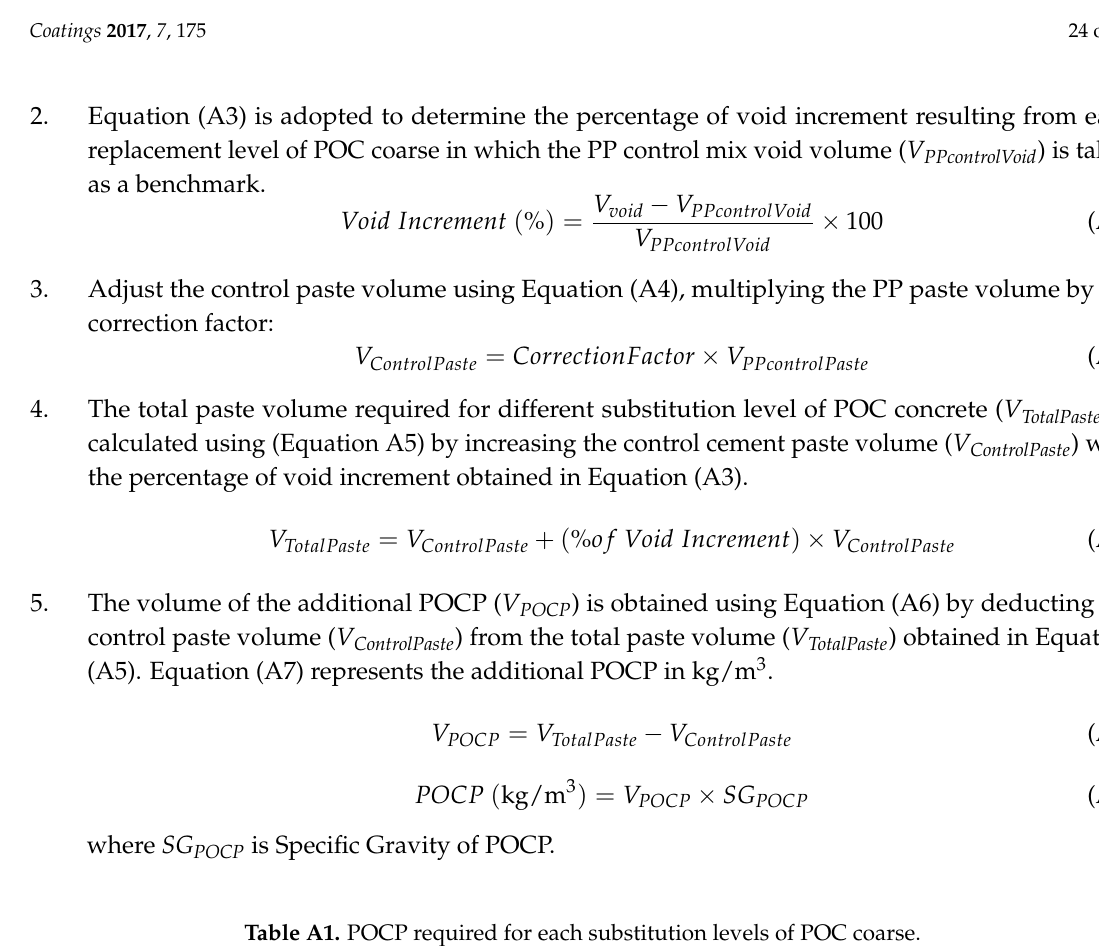
Table A1. POCP required for each substitution levels of POC